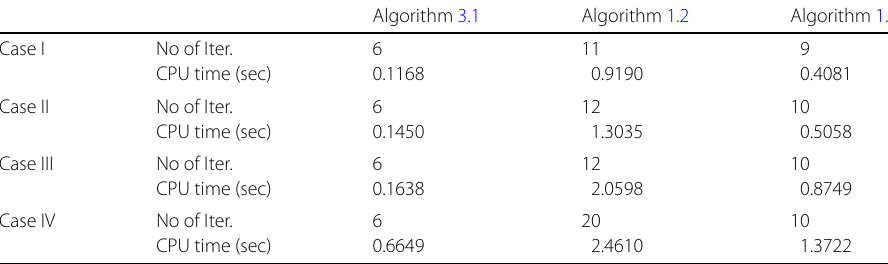
Table 1 Computational result for Example 4.1